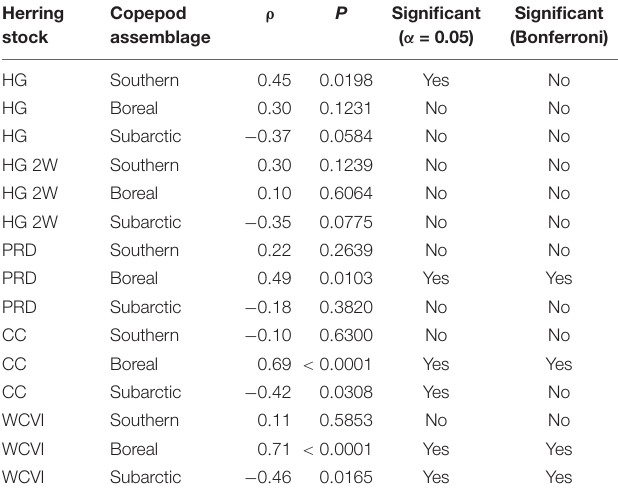
TABLE 5 | Spearman rank correlations between natural mortalities for five British Columbia herring stocks (Haida Gwaii, Haida Gwaii 2 West, Prince Rupert District, Central Coast, and West Coast of Vancouver Island) and abundance anomalies for three copepod assemblages (southern shelf, boreal shelf, and subarctic oceanic) off northwestern Vancouver Island